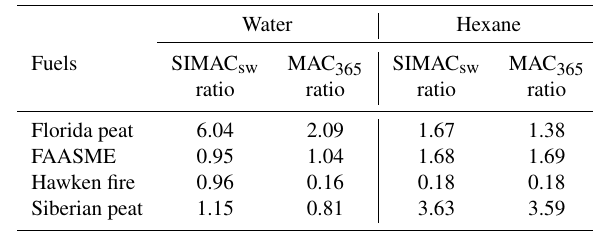
Table 1. Summary of SIMAC sw and MAC 365 (mass absorption coefficient at 365nm) values for water and hexane extracts of BB emissions from four analyzed